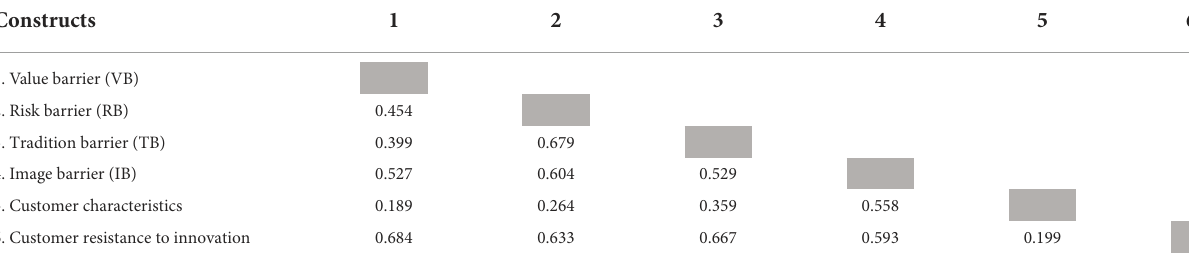
TABLE 4 Discriminant validity via HTMT.